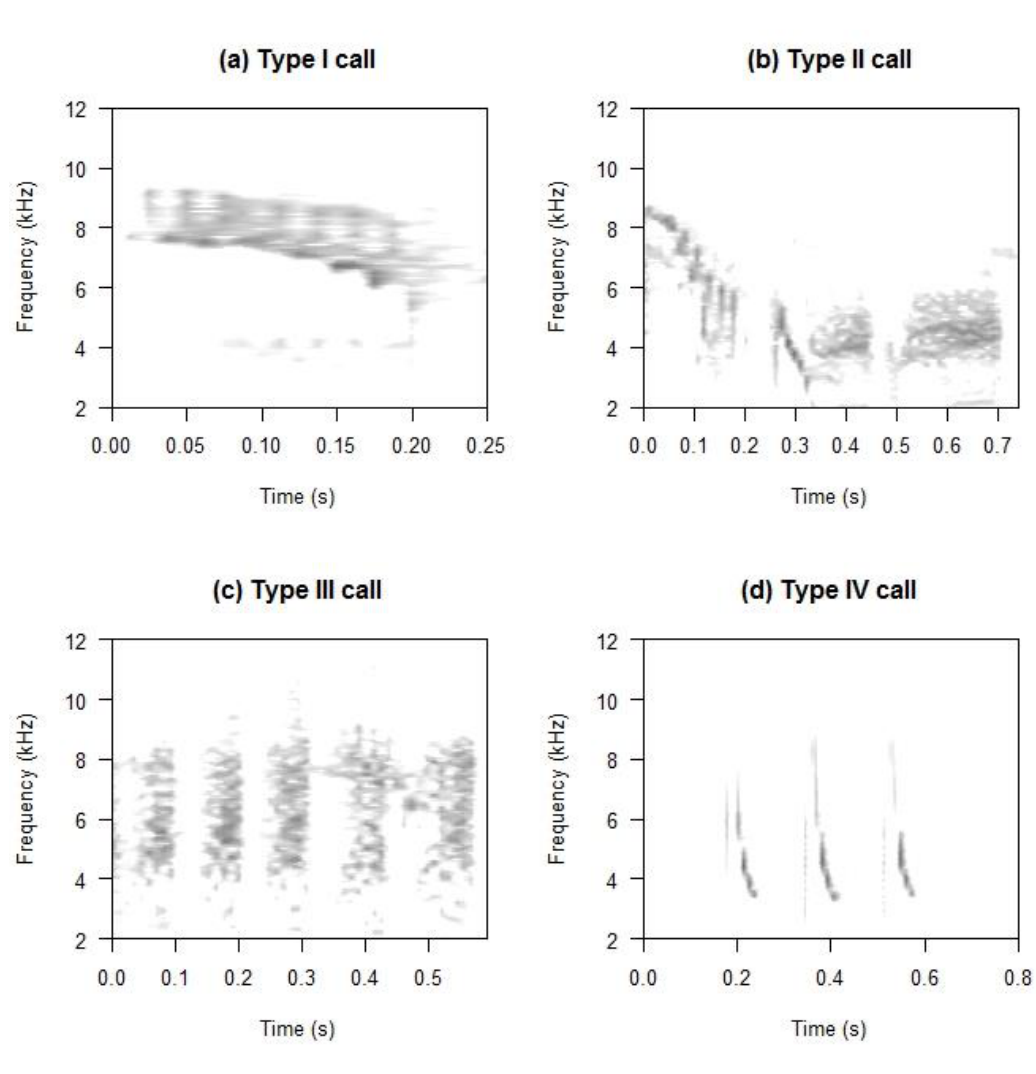
Fig. A1.1 . Examples of sound spectrograms of the mobbing calls of the marsh tit. We draw spectrograms of the type I, II, III calls using the recording used in the